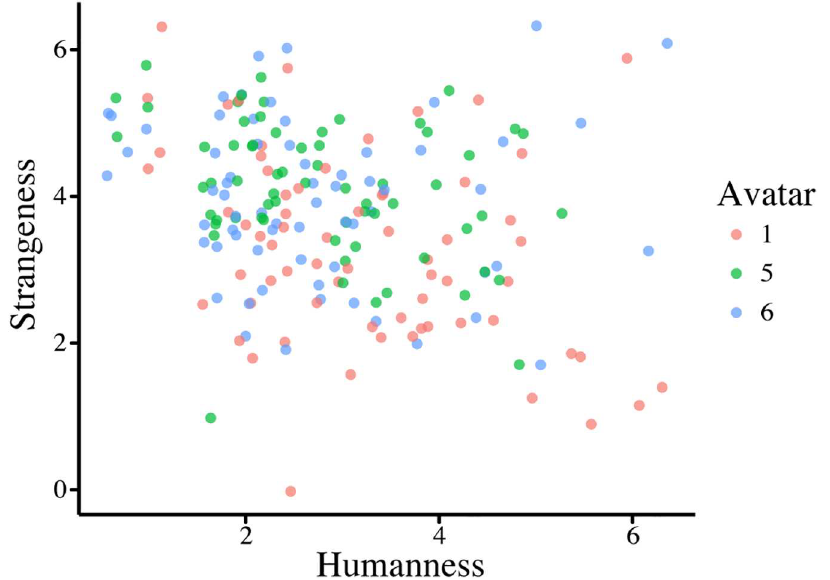
Fig 5. Individual ratings per Avatar. Shows that even thoughwe used a universalmanipulation, individual ratings of the avatars differ dramatically. Therefore analysiswill not be done on an avatar-by-avatar basis, but as a function of each participant’s